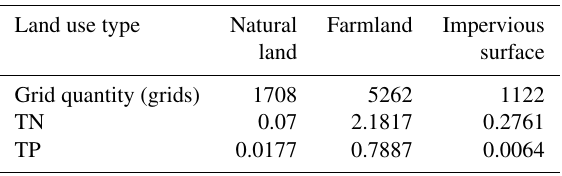
Figure 3. Reclassified land use and PS pollution input grid distri- bution. Table 1. Pollutant daily input amount for each land-use grid Units: kg/grid/day.